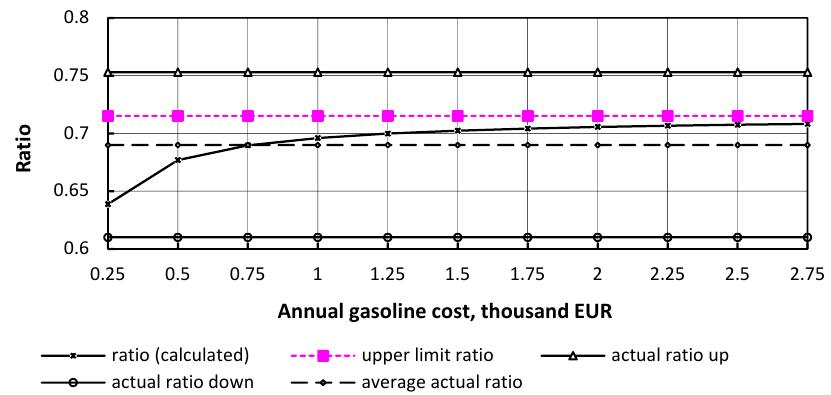
Figure 21. The dependence of the ratio of E85/gasoline prices on the annual conventional fuel cost (the USA).